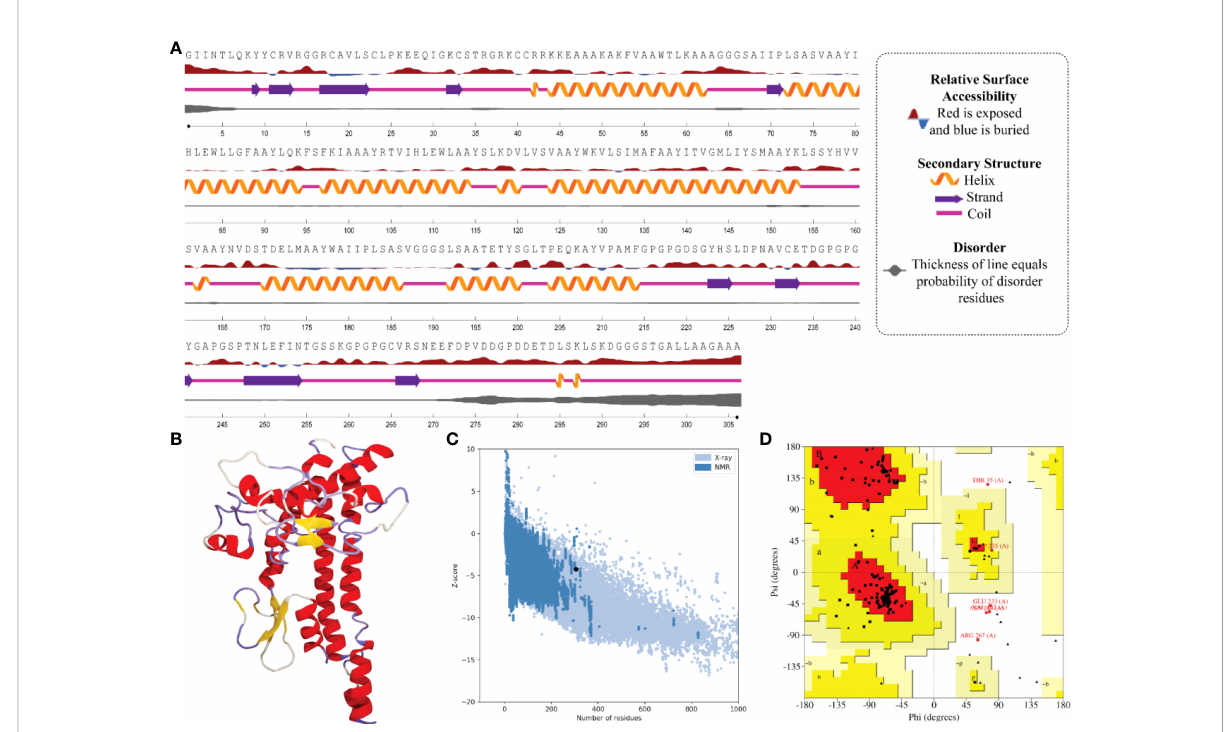
FIGURE 4 Structural analysis and validation of MPXV-2 (A) The predicted secondary structure features, relative surface accessibility, and disorder regions using NetsrurfP-3.0 server (B) Final 3D modeled structure of the constructed vaccine (C) Z-score graph via ProSA-web showing the modeled 3D structure corresponds to X-Ray crystallographic determined structure for the protein of similar sizes (D) Ramachandran plot details of the fi nal modeled structure of designed